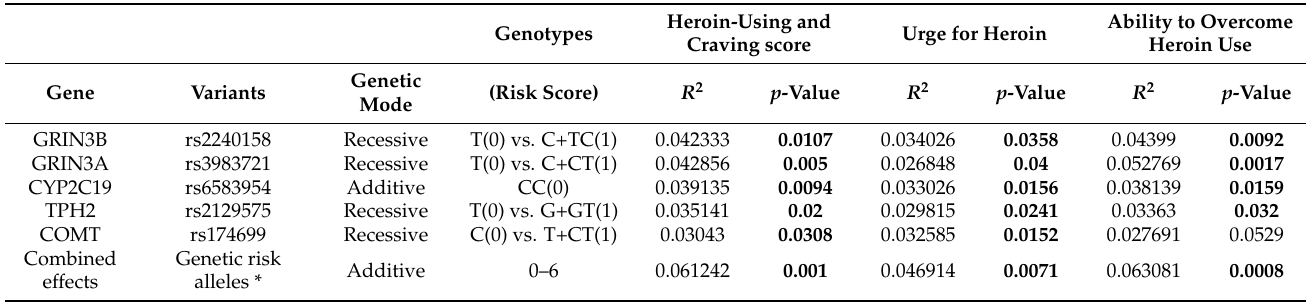
Table 4. Significant associations—combined effect of multiple genes in the different genetic modes. * Genetic risk alleles were generated from five significant